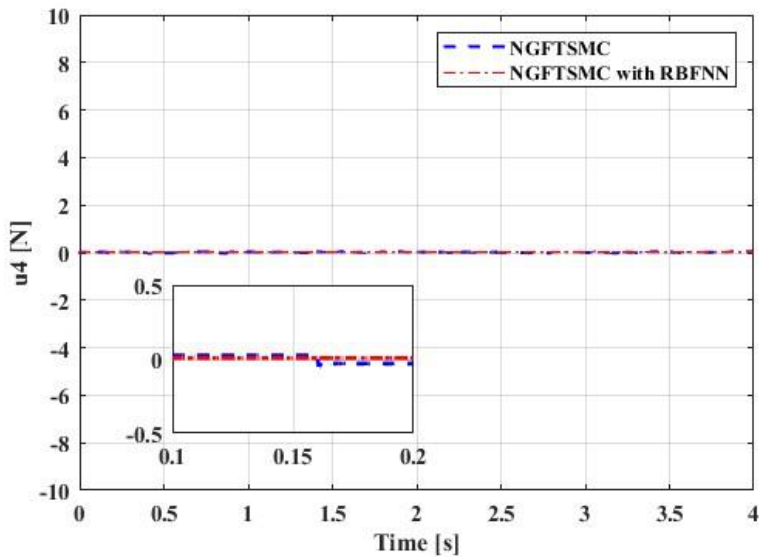
Figure 15. The performance of the control input 𝑢 4